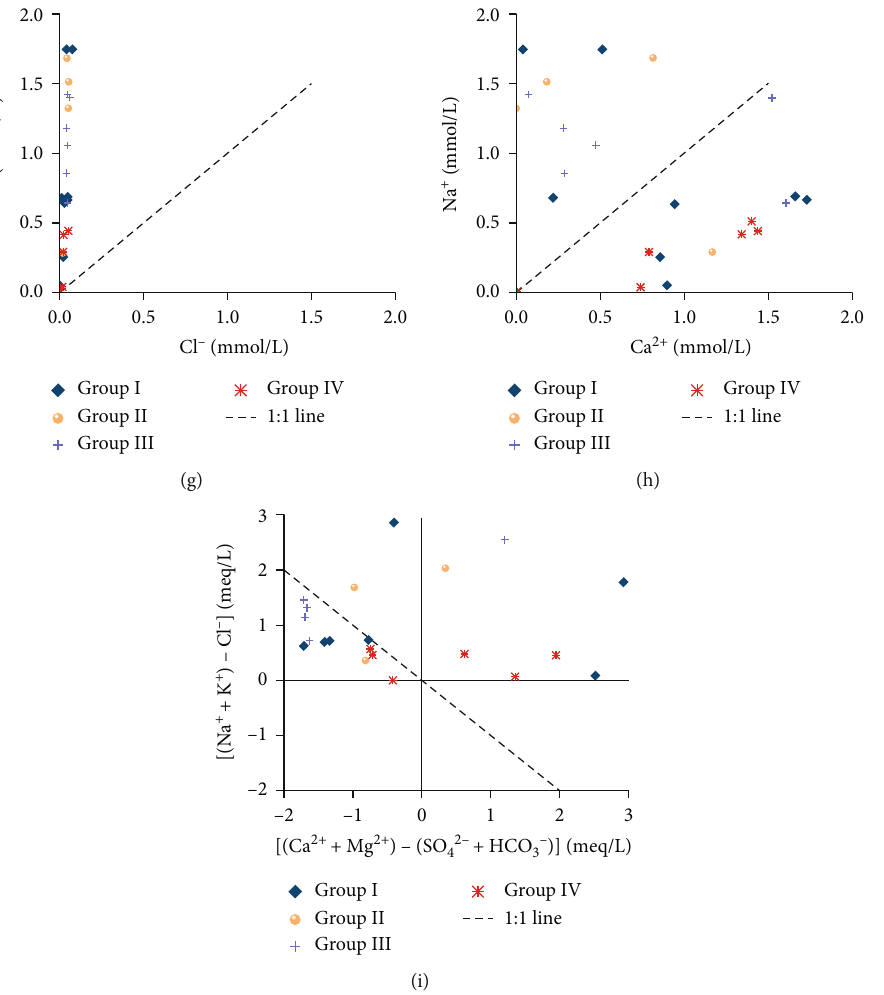
Figure 10: The relationship between the main ion ratios in the tunnel